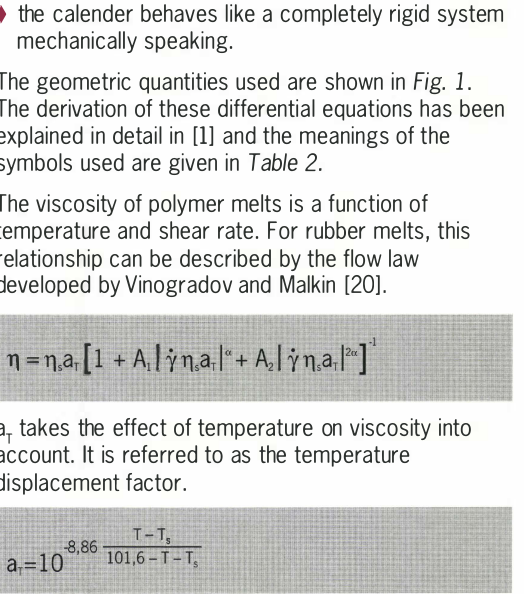
Abb. 4: Die Temperatur im Kalanderspalt fiir eine Temperatur der Walzen von �·= + 1.55 . 10"